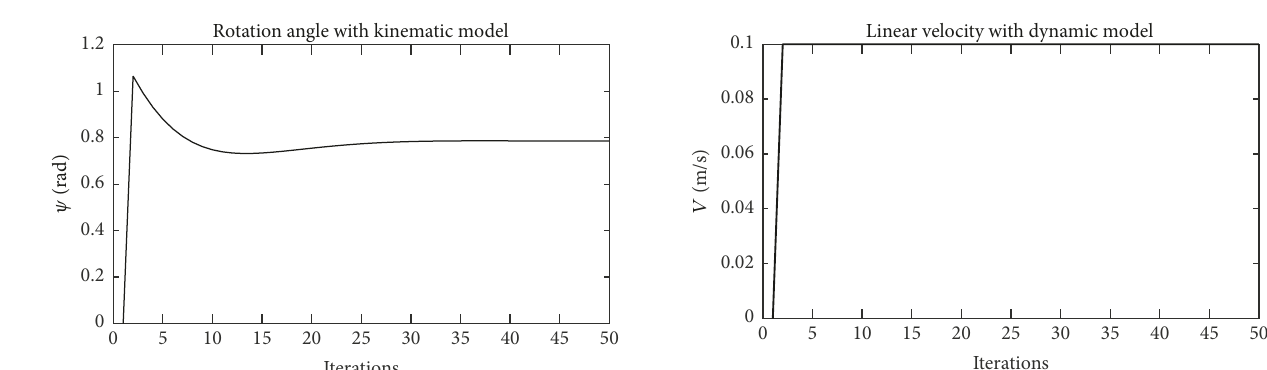
Figure 4: Rotation angle with the kinematic predictive control.